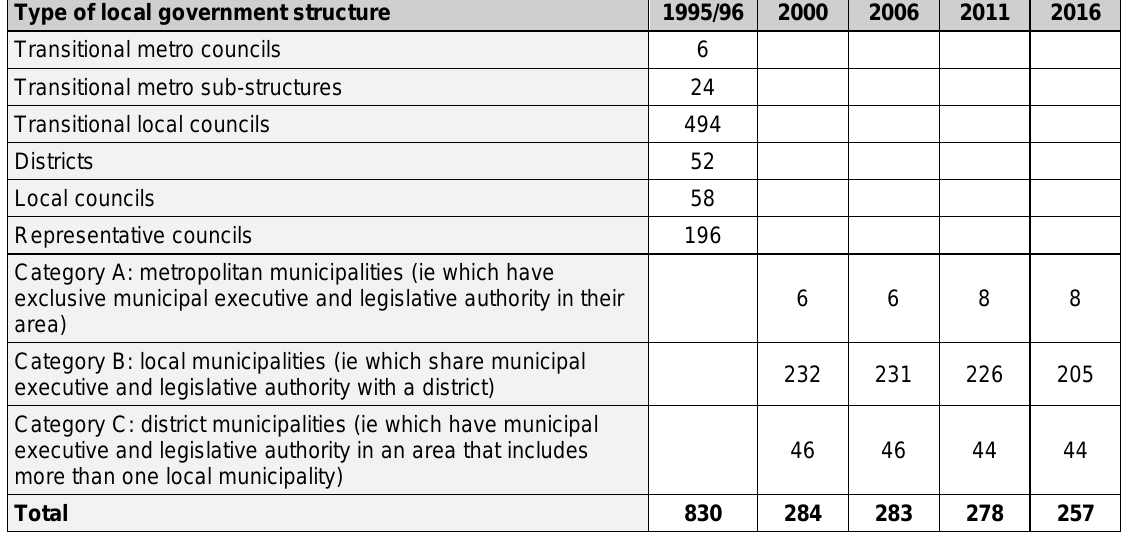
Table 1: Local government boundary demarcations in South Africa 1995–2016 Type of local government